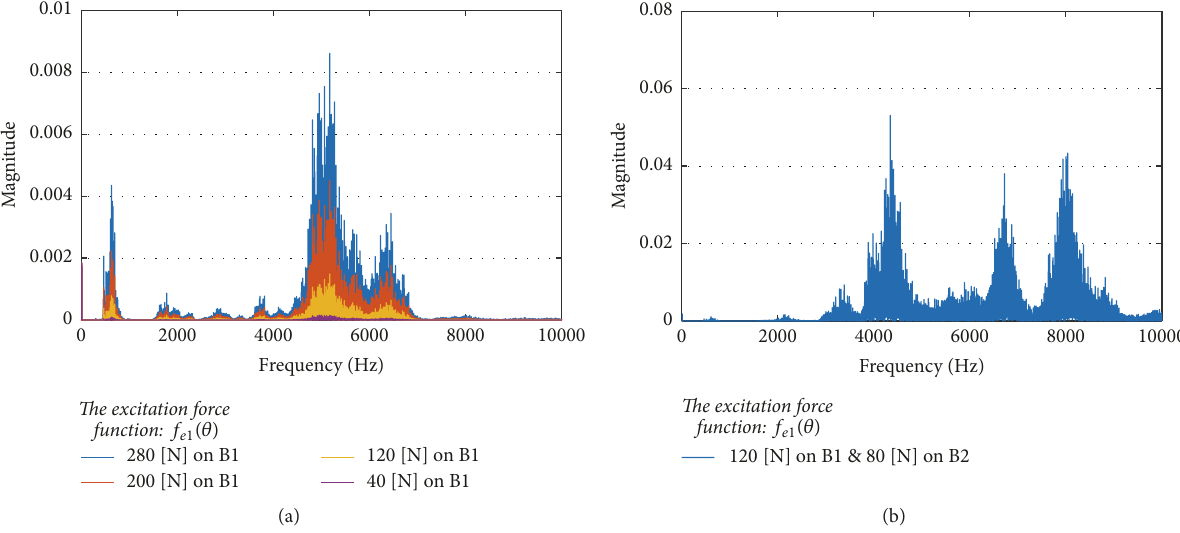
Figure 16: The power spectrum of the captured signal from S3 for (a) single faulty bearing (b) multiple faulty bearings.